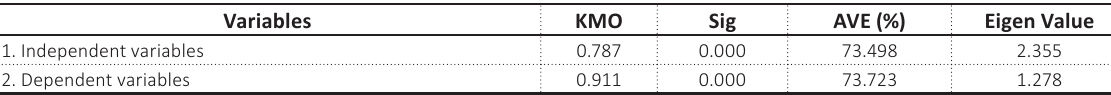
Table 3. EFA analysis results